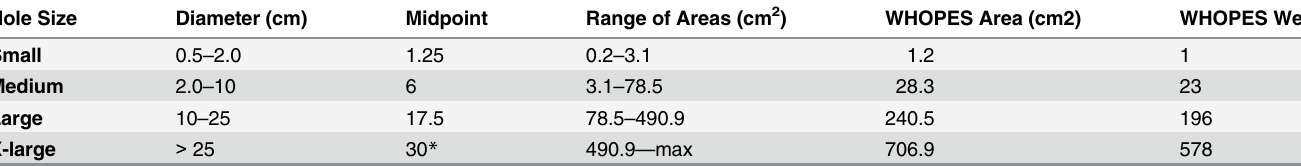
Table 1. Summary of WHOPES hole size categories, areas and corresponding